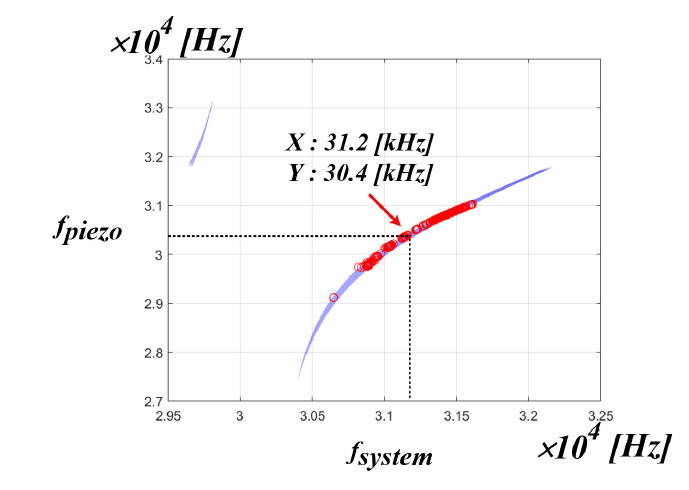
Figure 29. Curve fitting data